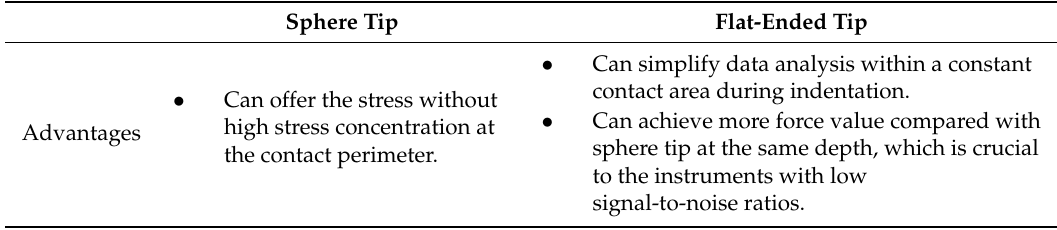
Table 2. Comparison between sphere and flat-ended tip for characterization of soft biomaterials Sphere Tip Flat-Ended Tip • Can simplify data analysis within a constant contact area during indentation. • Can offer the stress without • Can achieve more force value compared with high stress concentration at Advantages sphere tip at the same depth, which is crucial the contact perimeter. to the instruments with low signal-to-noise